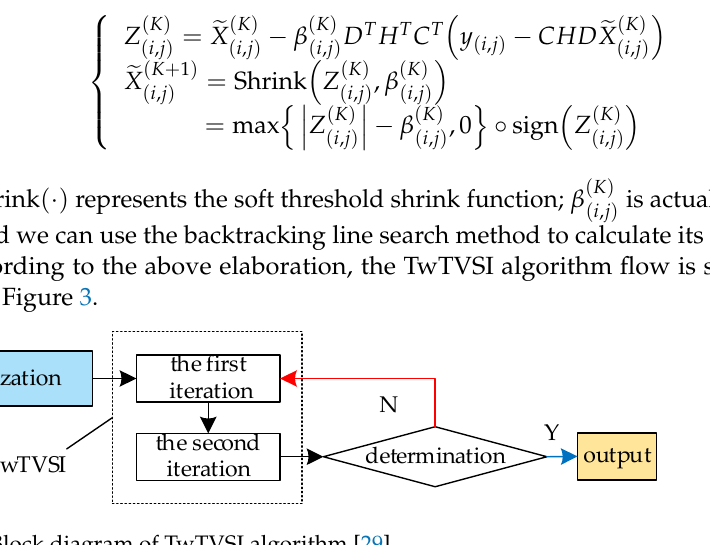
Figure 3. Block diagram of TwTVSI algorithm [29].